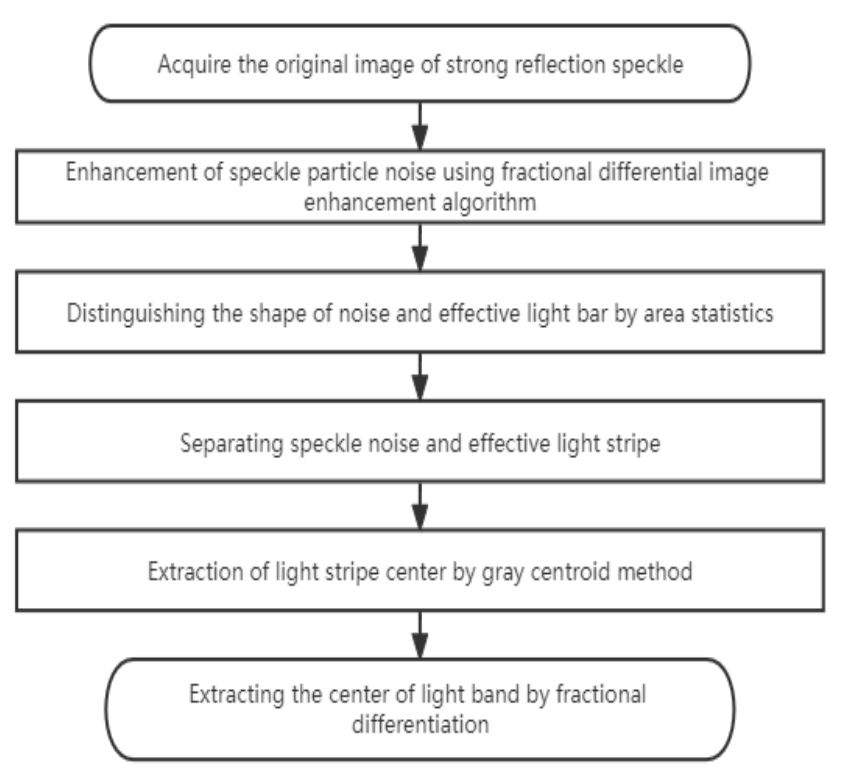
Figure 9. The extraction process of the light stripe center in the strong reflection area.